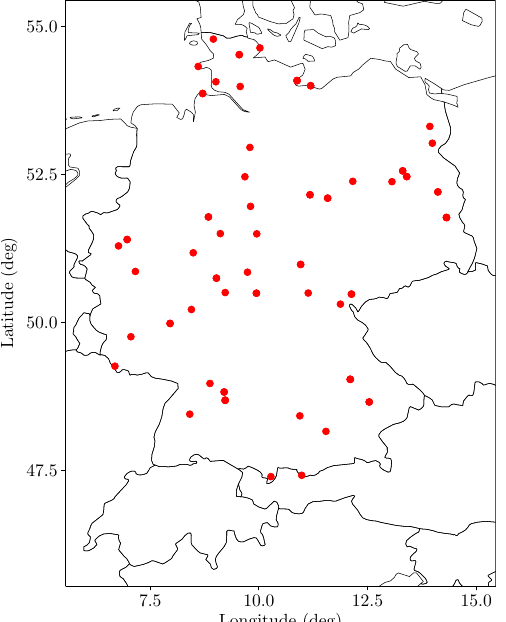
Figure 1. Map of Germany with the stations that were used for evaluation indicated as red